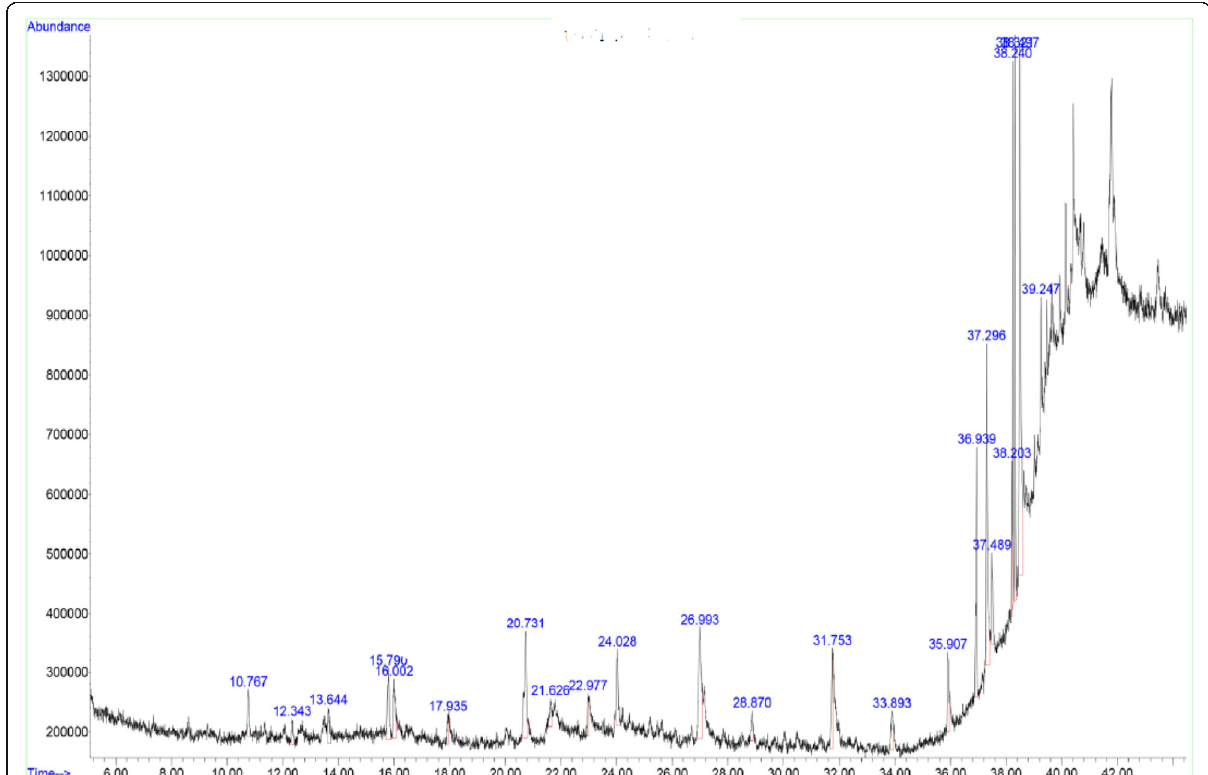
Fig. 1 GC-MS chromatogram of, aqueous methanol fraction of Hibiscus asper